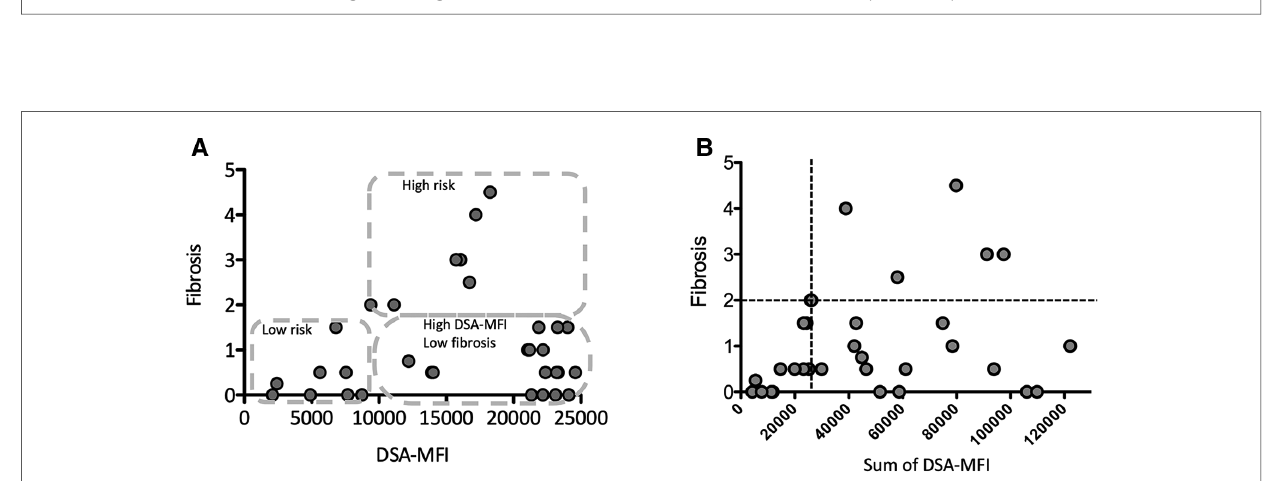
FIGURE 3 The correlation between the maximum ( A ) or sum of ( B ) the DSA-MFI and graft fi brosis. ( A ) The pediatric LT patients who developing post-transplant DSA were divided into 3 groups by the DSA-MFI cut-off value (9,300) and a fi brosis score of 2. ( B ) A graft fi brosis score of 2 (dotted line) and a DSA-MFI sum of 2,500 (dotted line) were used as cut-off values. The values of DSA-MFI and histological fi ndings were collected at the time of the fi rst detection of post- transplant